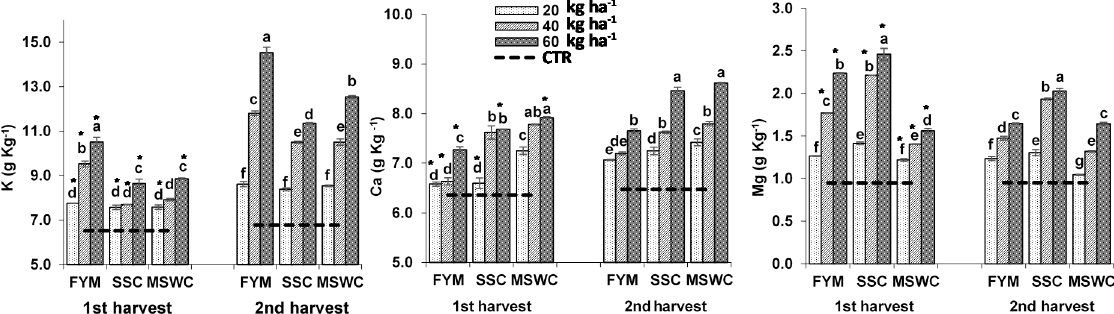
Figure 6. Effects of the soil amendment with different doses (20, 40, 60 t ha − 1 ) of farmyard manure (FYM), sewage sludge compost (SSC) or municipal solid waste compost (MSWC) on N contents in barley grains, stems and roots. CTR: una- mended soil. Lower case letters indicate significant differences between treatments within the same harvest time. Asterisks indicate significant differences between harvest time within each treatment over time (* p < 0.05).